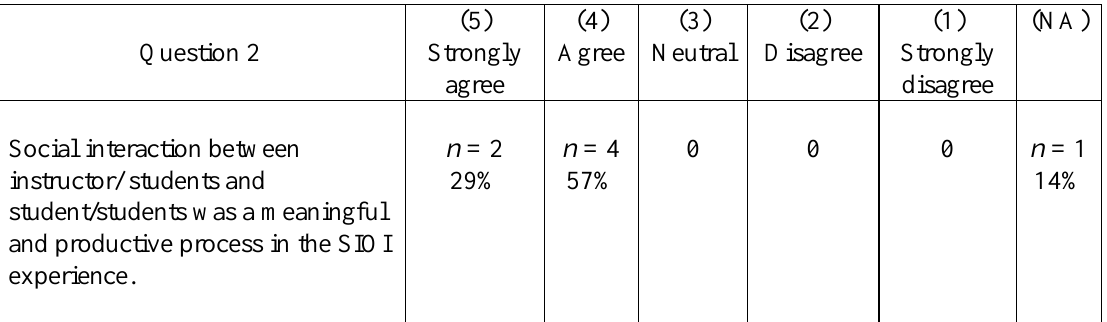
The Nature of Social Interaction in SIOI